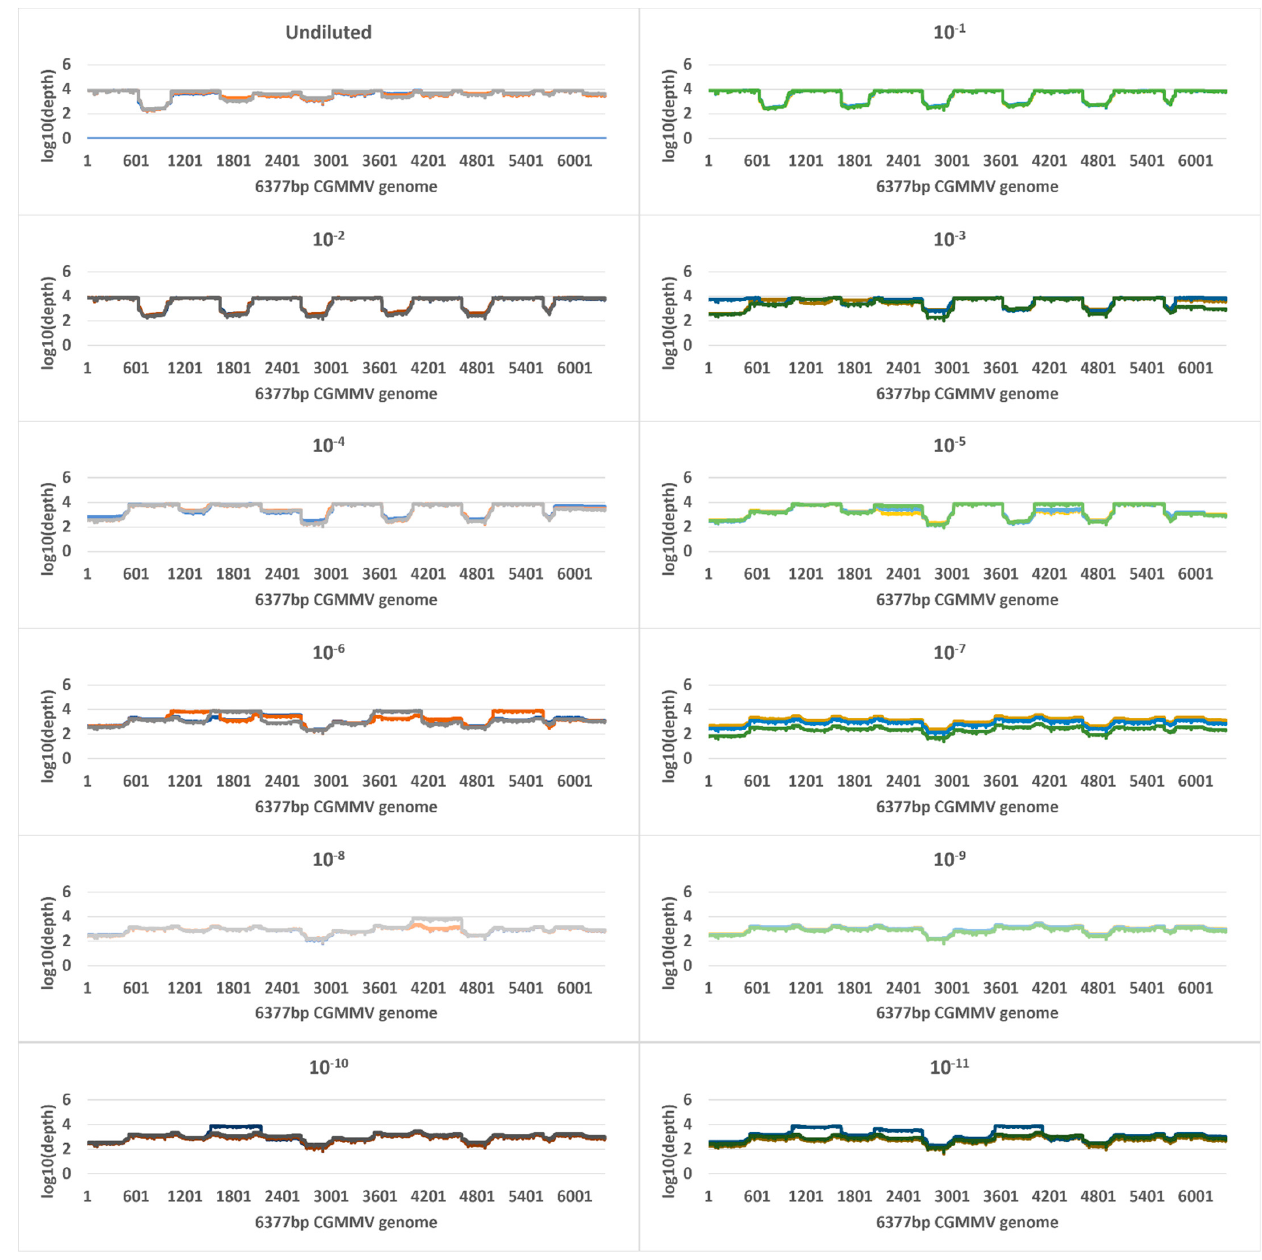
Figure 2. Genome coverage and read depth profiles of plant panel tenfold dilution series samples, from undiluted to 1 in 100,000,000,000 (10 − 11) across the 6377 nt cucumber green mottle mosaic virus (CGMMV) genome (VPRI43306) detected using tiled amplicon nanopore sequencing. Each dilution was tested in triplicate and the results for each technical replicate are shown as different colours. Depth is in standard logarithmic scale.